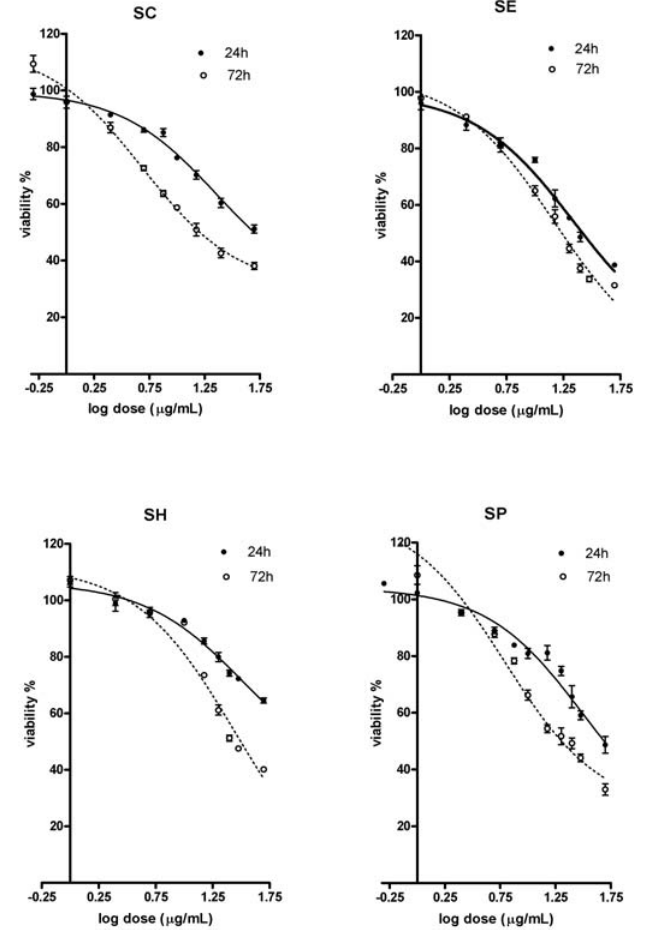
Figure 1. Antiproliferative activities (MTT test) of leaves water extracts from Staphylea L. The dose response curves after 24 and 72 h exposure of A431 skin carcinoma cells to tested extracts (SC - S. colchica ; SE - S. elegans ; SH - S. holocarpa ; SP - S. pinnata ).